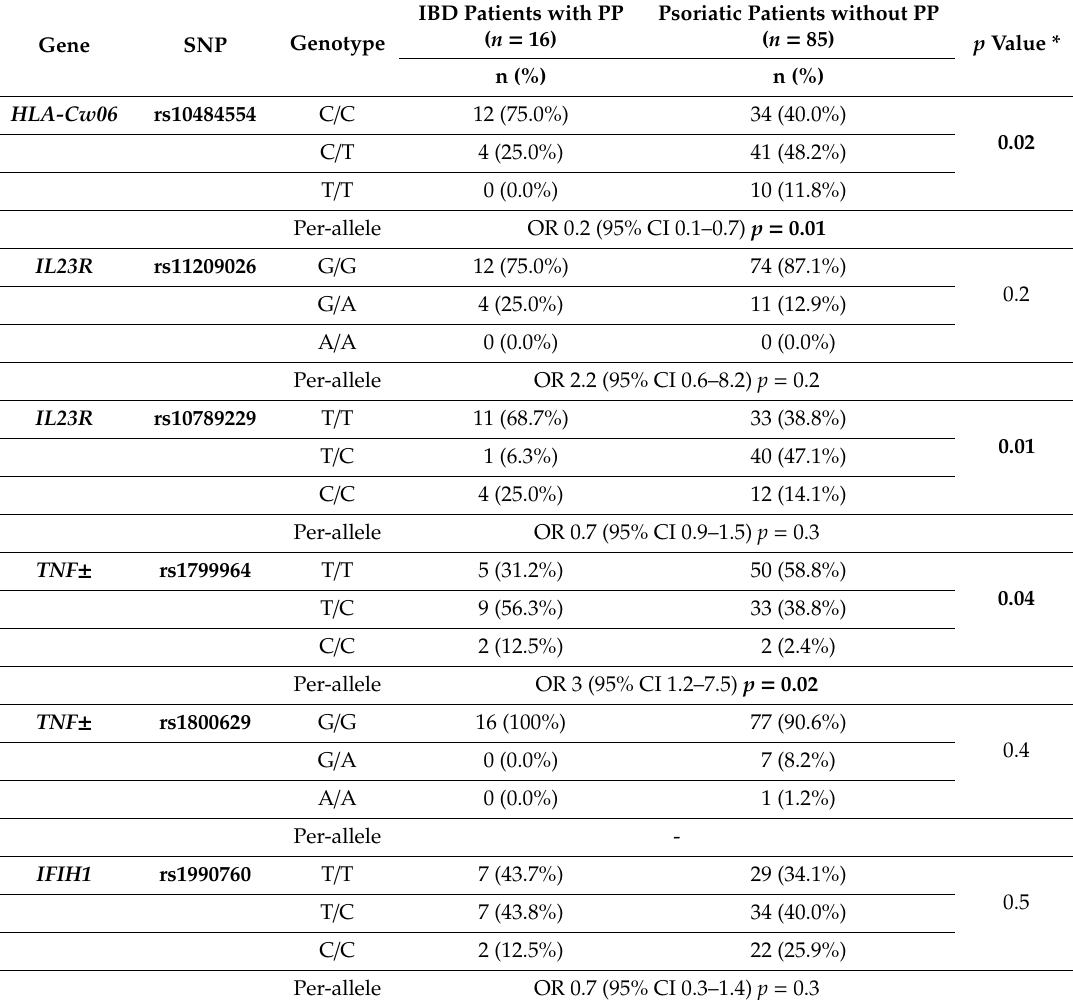
Table 4. Distribution of IBD patients with PP and psoriatic patients without PP according to the genotype frequencies of the six SNPs